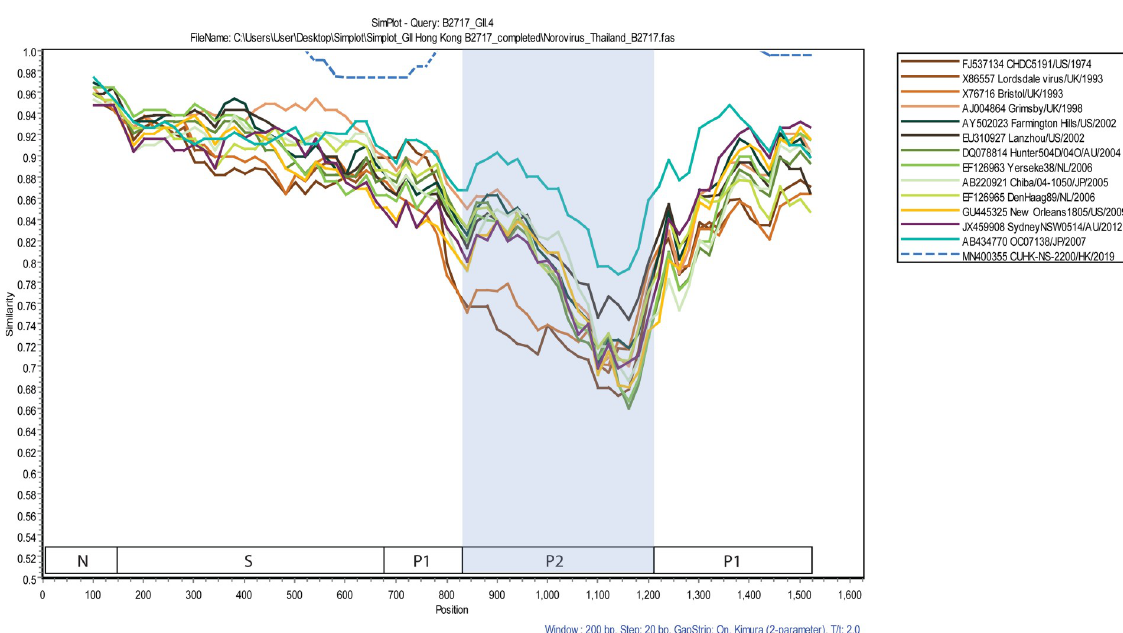
Fig 3. Pairwise nucleotide similarities between the complete VP1 sequence of the Thai GII.4 Hong Kong (B2717) and those of 14 other pandemic and non-pandemic GII.4 reference strains (shown in different colors). Analysis was performed using SimPlot program version 3.5.1 with B2717 as a query strain. N = amino-terminal, S = shell, and protruding domains P1 and